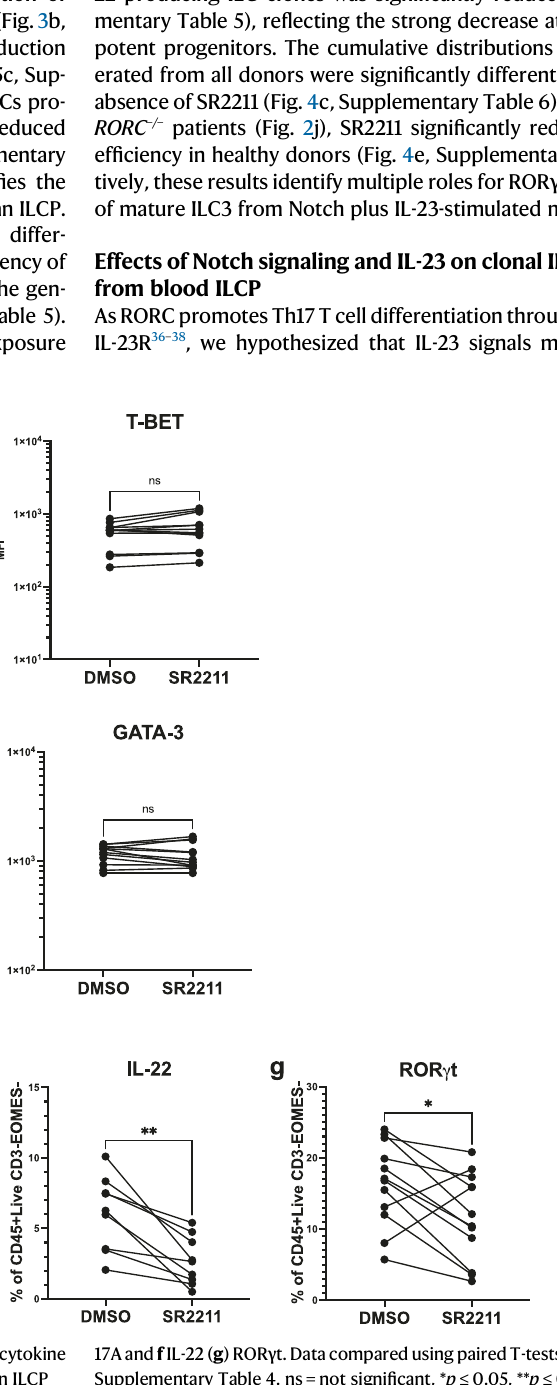
Supplementary Table 4. ns=not signi fi cant, * p ≤ 0.05, ** p ≤ 0.01, *** p ≤ 0.001, **** p <0.001. Data are presented as individual unique donors matched across conditions.Resultsfrom3( a , c , e , f )or4( b , d , g )independentexperiments.Source Data are provided as a Source Data fi